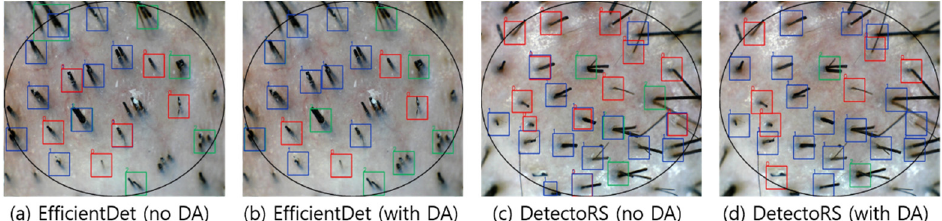
Figure 8. Visualization of detection results with and without data augmentation (DA: data augmen ‐ tation).